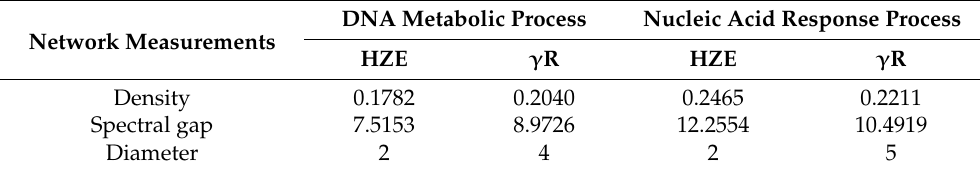
Table 6. Network measures for the subnetworks for very high HZE and γ R radiation dose DDR processes. Network